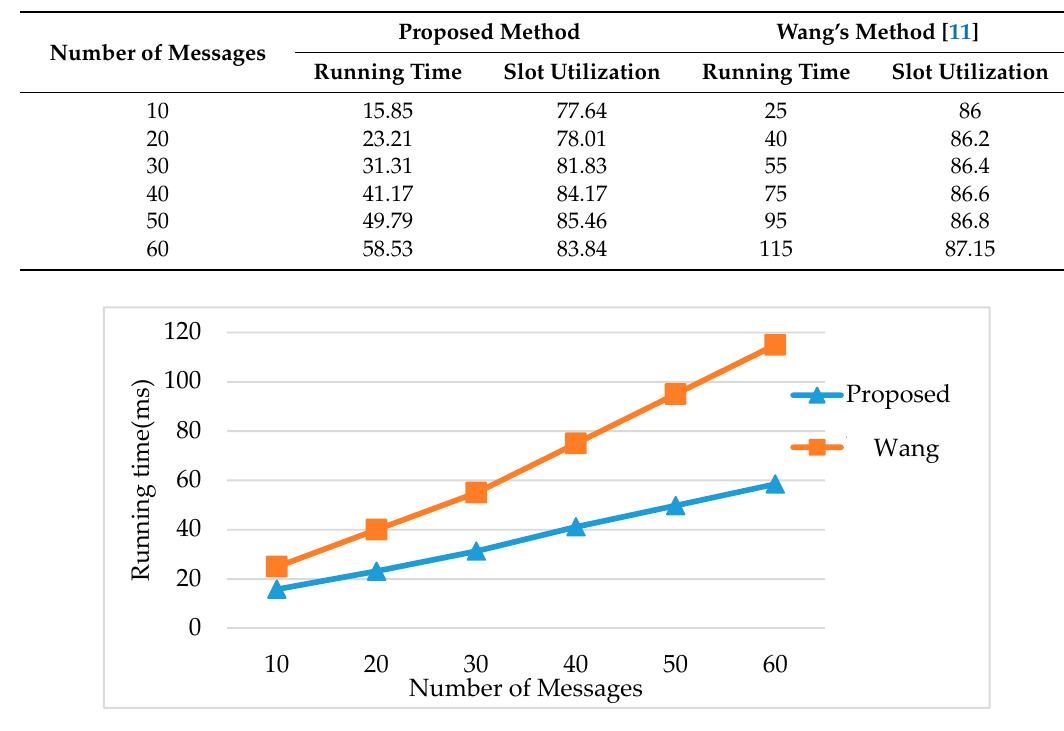
Figure 5. Comparison of running time with Wang’s method.